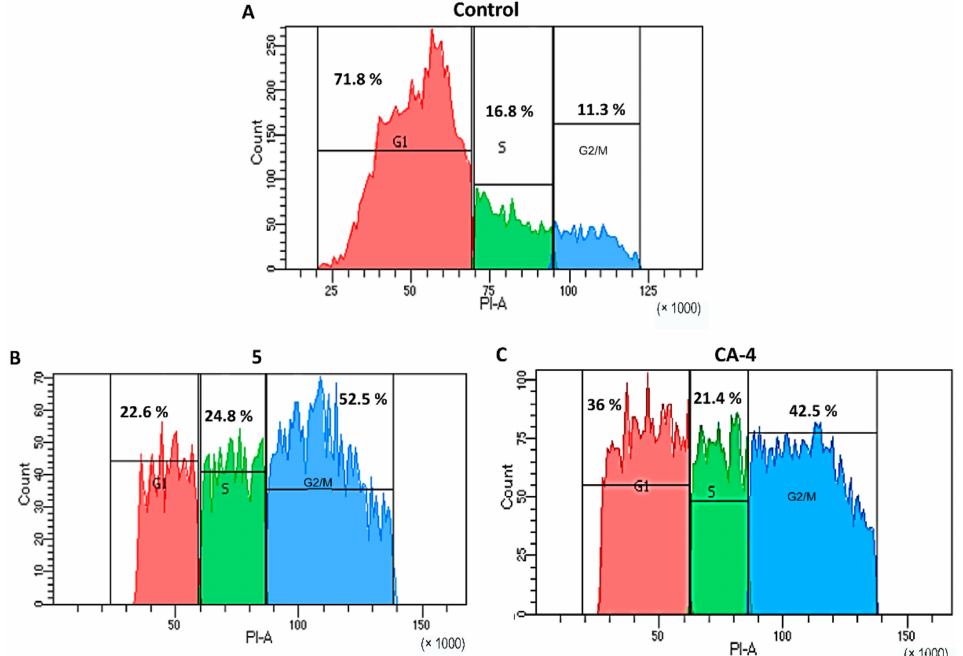
Figure 5. Analysis of cell cycle progression of HeLa cells by flow cytometry: ( A ) Control cells, ( B ) treated with compound 5 , ( C ) treated with CA-4 . HeLa cells were treated with compound 5 (0.16 µ M) and CA-4 (1.49 µ M) for 48